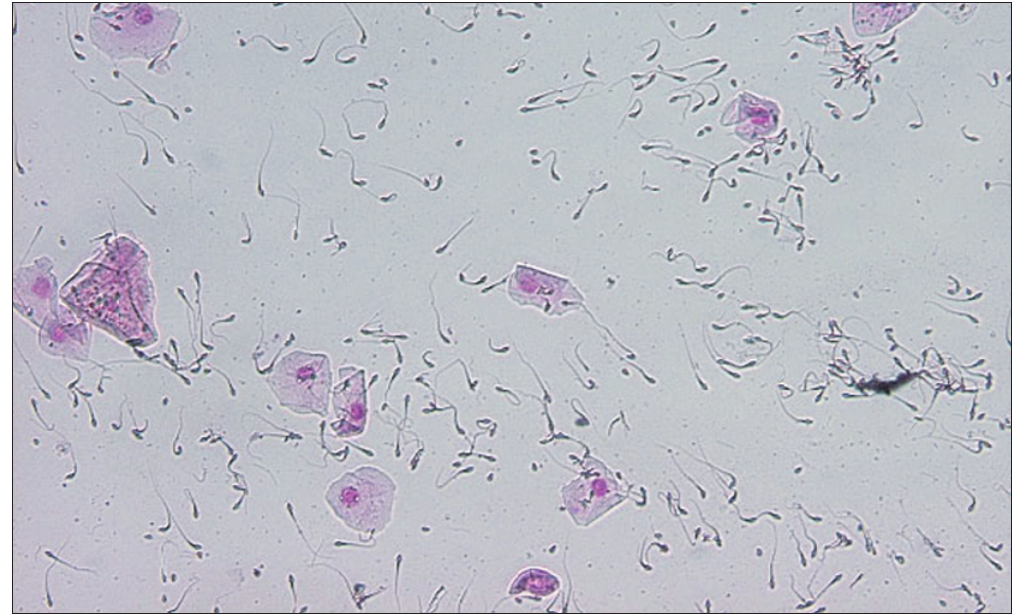
Fig. 7. Freja's vaginal smear on August 3, 2000 (x 100, Wright-Giemsa coloration). Vaginal epithelial cells and spermatozoids can be